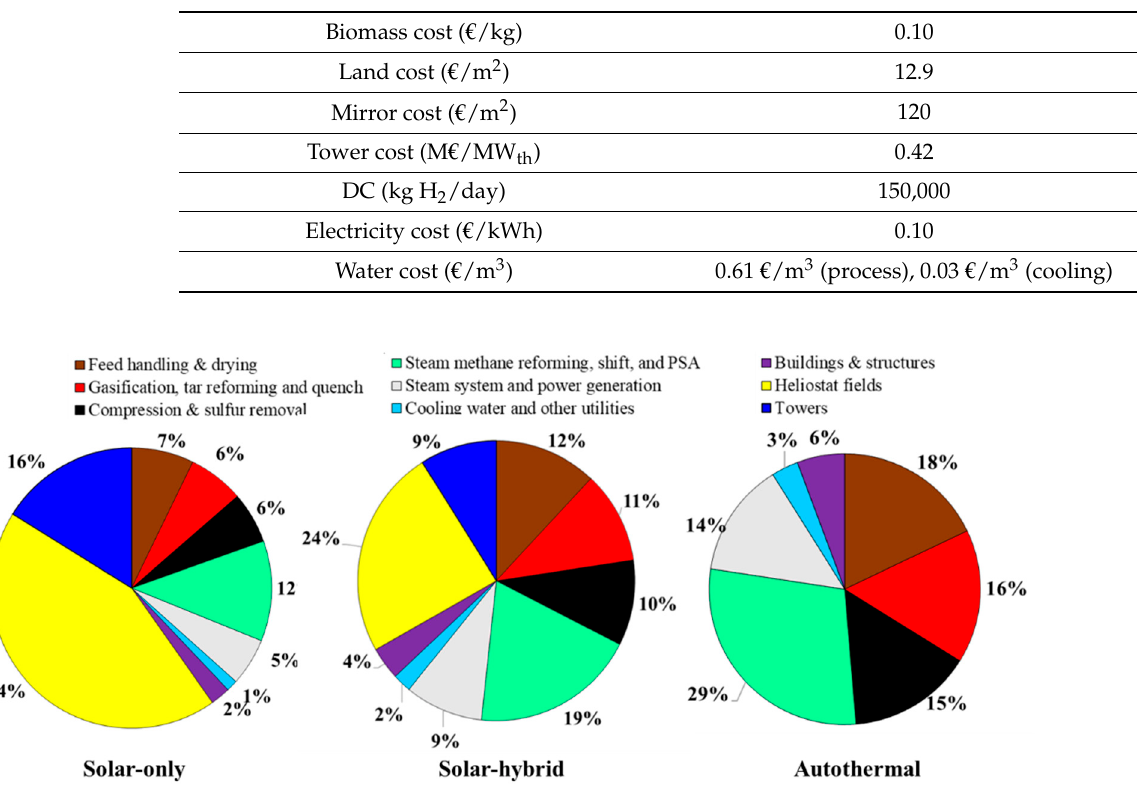
Figure 3. Direct capital investment breakdown (at reference assumptions, Table 5).